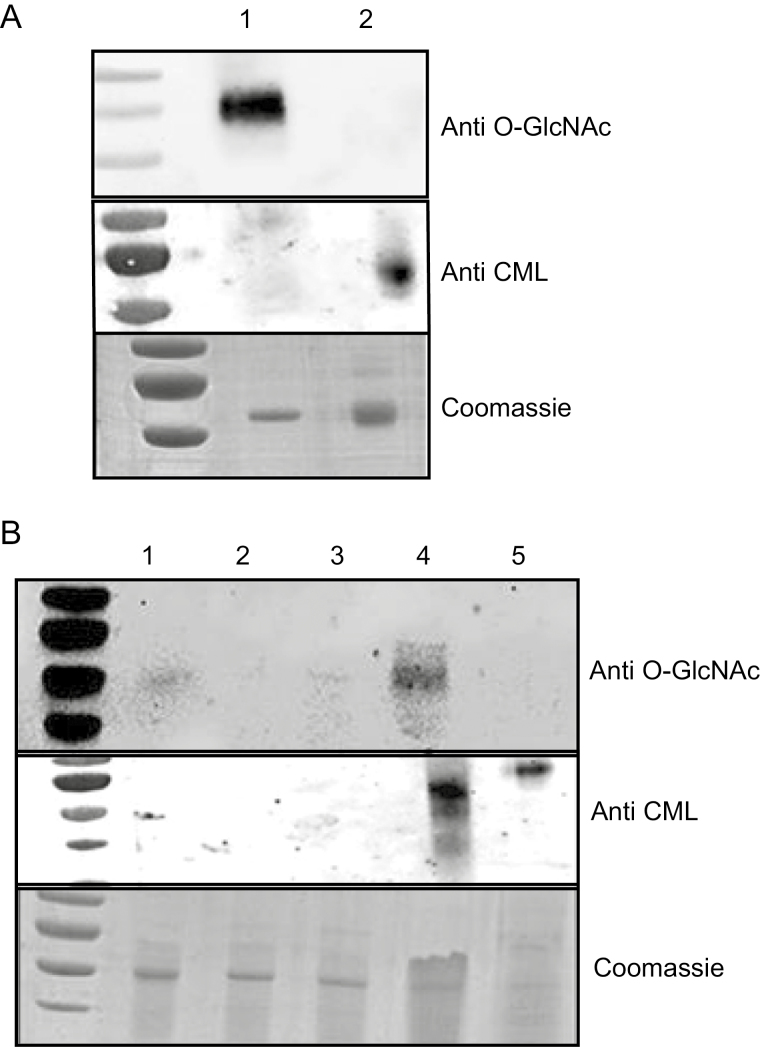
Enrichment for protein glycation after alkaline hydrolysis. (A) Specificity of anti-CML and anti-O-GlcNAc antibodies using modified BSA. Lane 1, O-glycosylated BSA (Thermo Fisher, UK); lane 2, non-enzymatically glycated BSA (see the Materials and methods). Top: a western blot hybridized with anti-O-GlcNAc. Middle: a western blot hybridized with anti-CML. Bottom: a Coomassie stain of an SDS–PAGE gel transferred onto a nitrocellulose membrane before western blot analysis. (B) Enrichment for glycated proteins before and after alkaline hydrolysis of total leaf extracts. Lane 1, total protein extract; lanes 2 and 3, non glycated peptide peaks; lane 4, glycated peak prior to alkaline hydrolysis; 5, glycated peptide peak post-alkaline hydrolysis. Top: a western blot hybridized with anti-O-GlcNAc. Middle: a western blot hybridized with anti-CML antibody. Bottom: a Coomassie stain of an SDS–PAGE gel before transfer to a nitrocellulose membrane for western blot analysis.